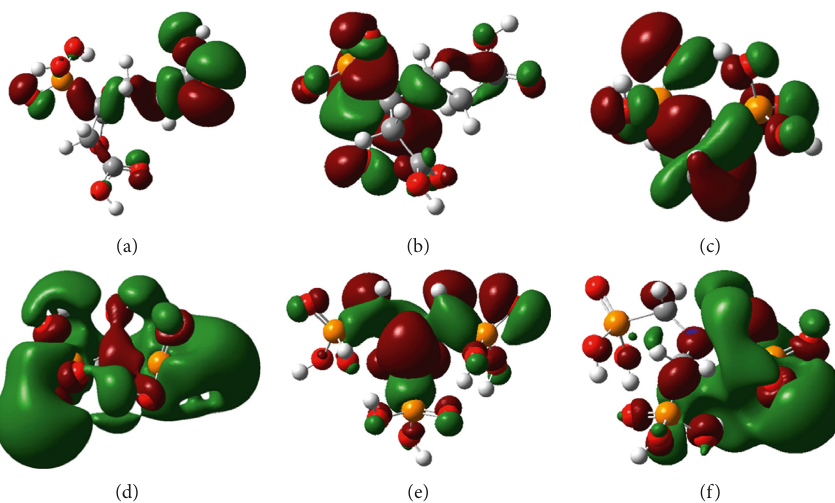
Figure 5: Optimized frontier orbitals of organic phosphorus inhibitors. (a) HOMO of PBTCA. (b) LUMO of PBTCA. (c) HOMO of HEDP. (d) LUMO of HEDP. (e) HOMO of ATMP. (f) LUMO of